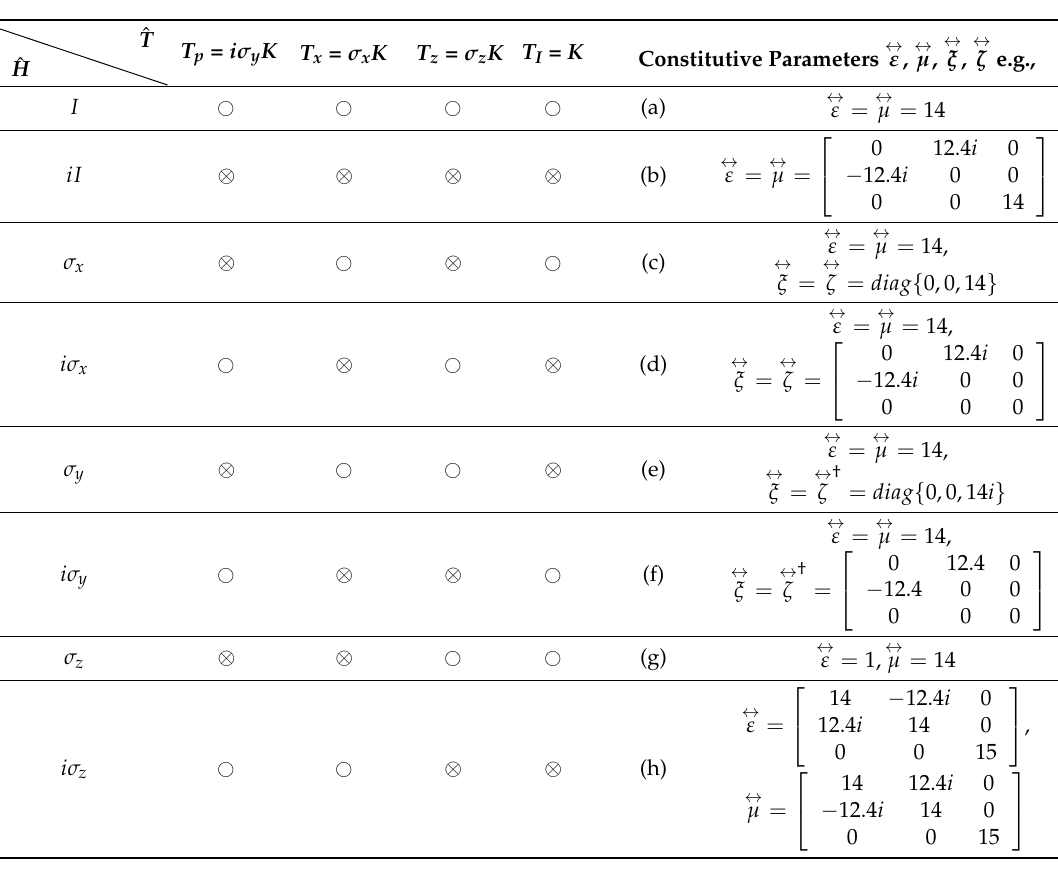
( r = 0.11 a ) is placed at the center of waveguide. If there is backscattering, the corresponding impurity is considered to break the robustness. Table 1. Commutation results between all Hamiltonian and symmetry operators. The symmetry type of each Hamiltonian (a two by two complex matrix) is determined via its constitutive equation (the last column). We list all kinds of commutation results between the Hamiltonians and four symmetry operators (three Pauli matrices and one identity matrix with a complex conjugate operator). Circle marks mean commutation while cross marks mean